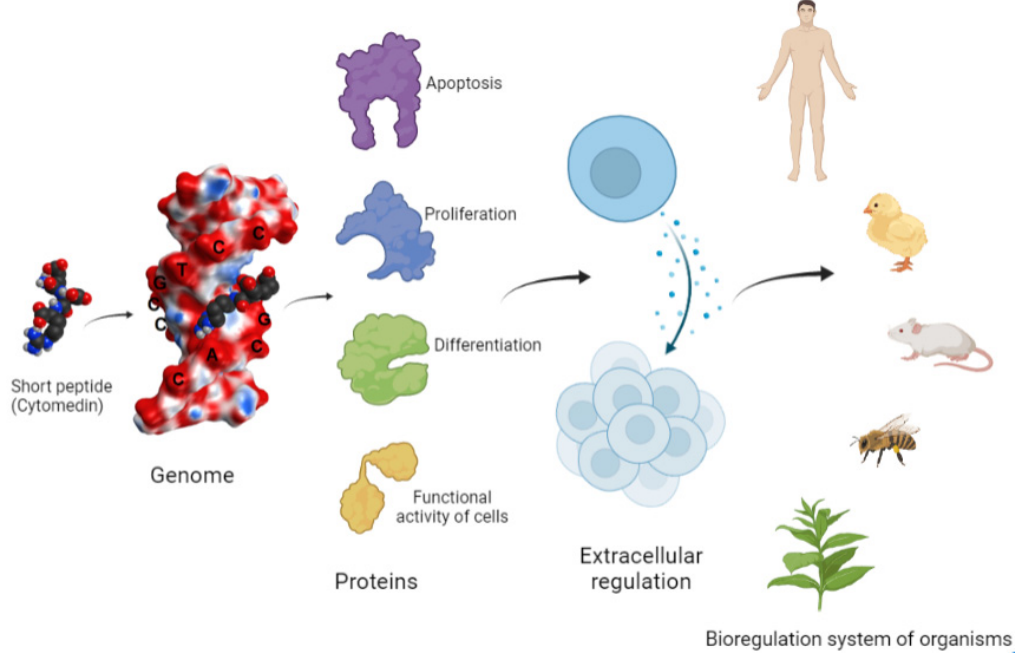
Figure 1. Bioregulation system of a multicellular organism (according to Morozov and Khavinson, 1983, with modifications) [11].